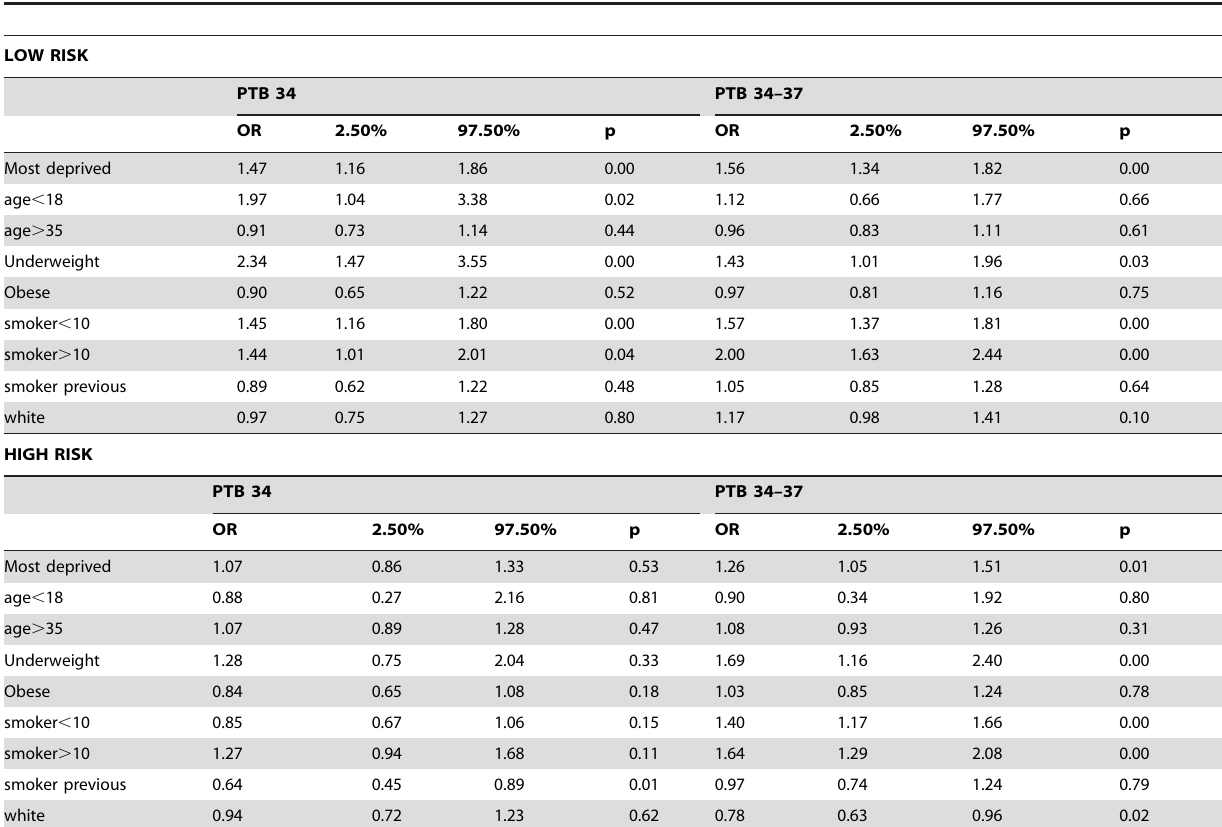
Table 2. Univariate regression assessing association between covariates and PTB in low and high risk group.